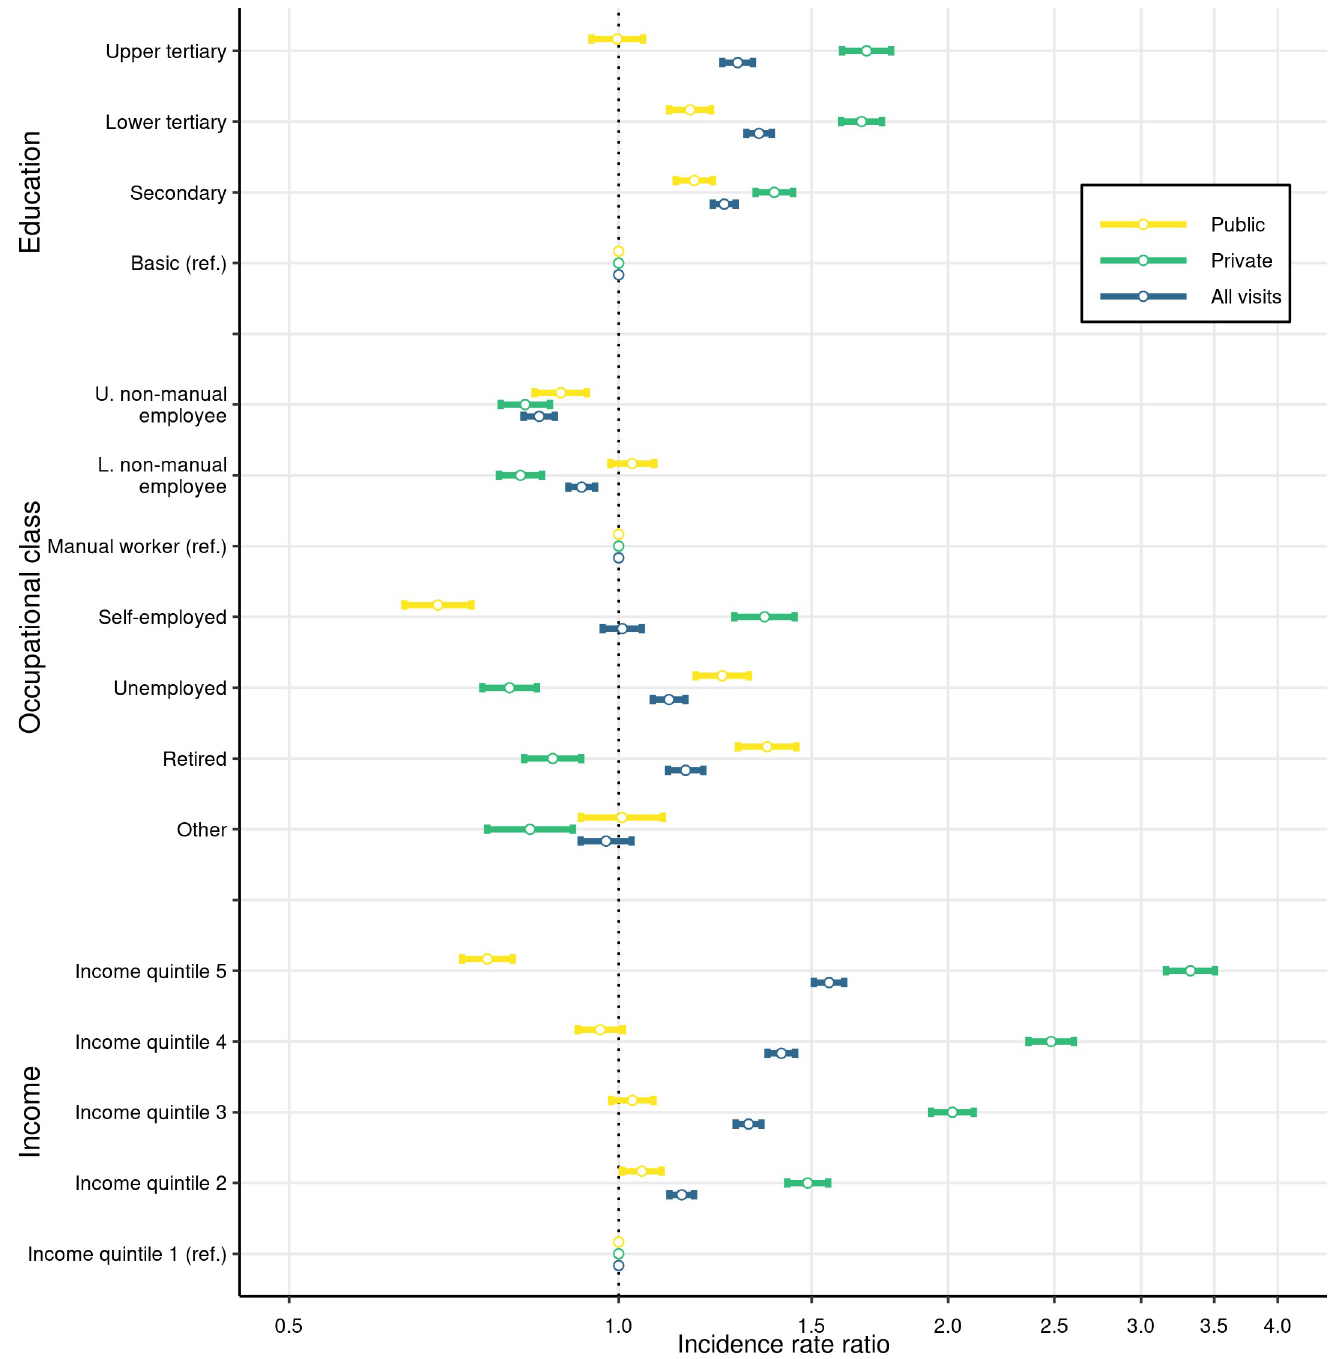
Fig 3. Negative binomial model incidence rate ratios for the number of public, private and all visits, with their 95% confidence intervals. Study population: non-student (aged over 25) residents of Oulu, Finland, in 2017–2018 (N = 118,397). Other covariates included in the model but not shown in the figure are sex and age groups 25–34, 35–44, 45–54, 55–64, 65–74, and over 75. The results for each dependent variable are estimated from separate regressions. The x-axis is scaled using log of base 10. The vertical dashed line is set at IRR = 1.